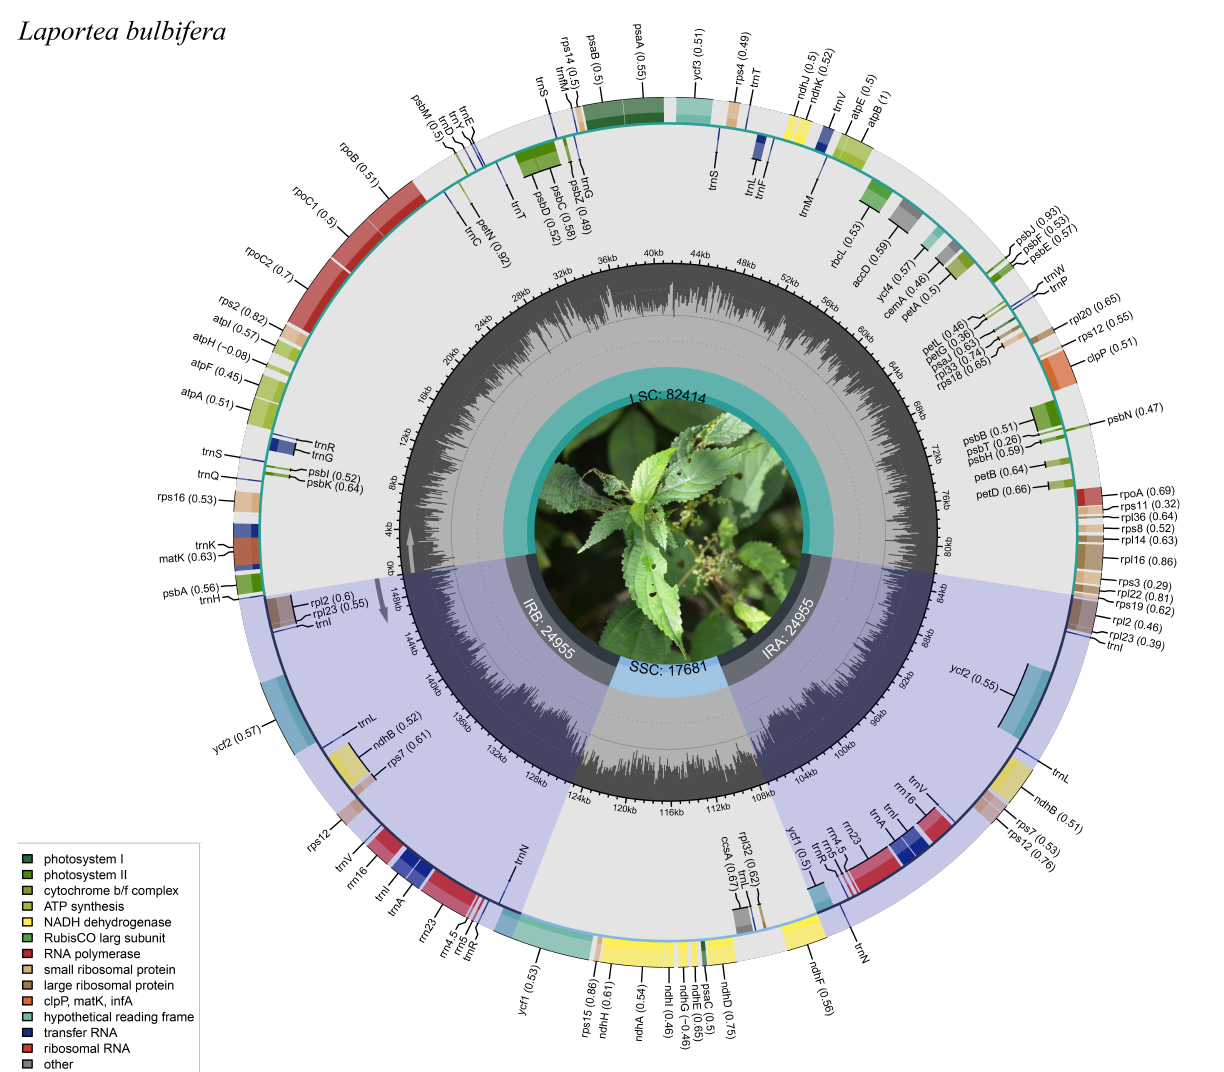
Figure 1. The plastome genome map of Laportea bulbifera ( L. bulbifera ) created by